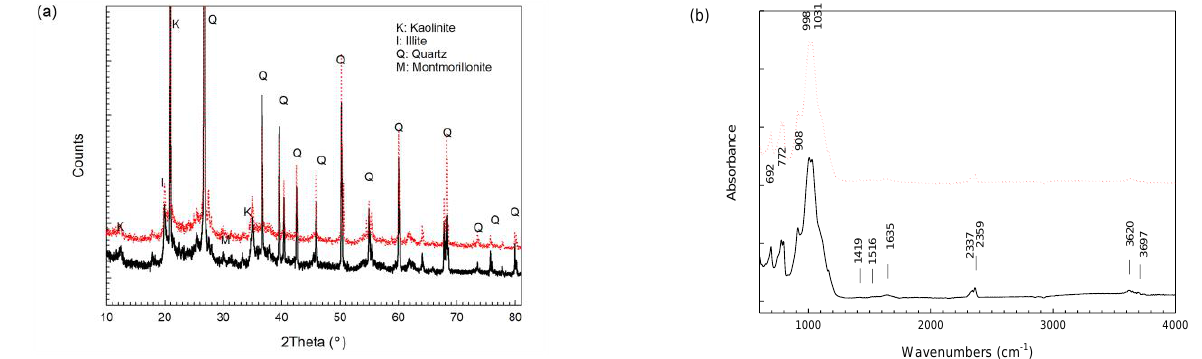
Figure 3. ( a ) XRD and ( b ) FTIR spectra of soil before and after washing. The solid black line represents soil before washing and the dotted red line represents soil after washing.